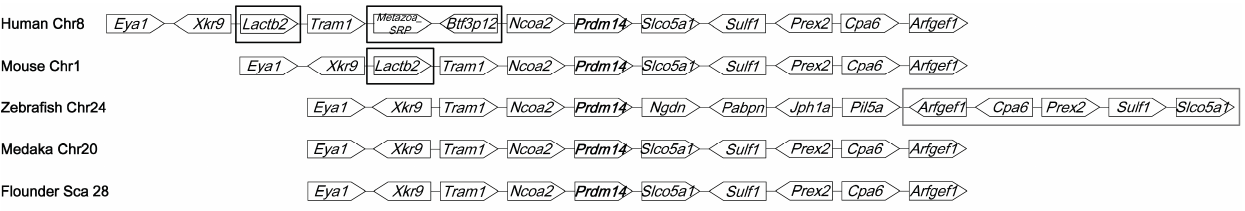
Figure 5. Chromosome localization analysis of prdm14 . Chromosome synteny of fish and mammalian prdm14 genes. The differences among human, mouse, and zebrafish sequences were marked with black and grey frames. Chr, chromosome, Sca,